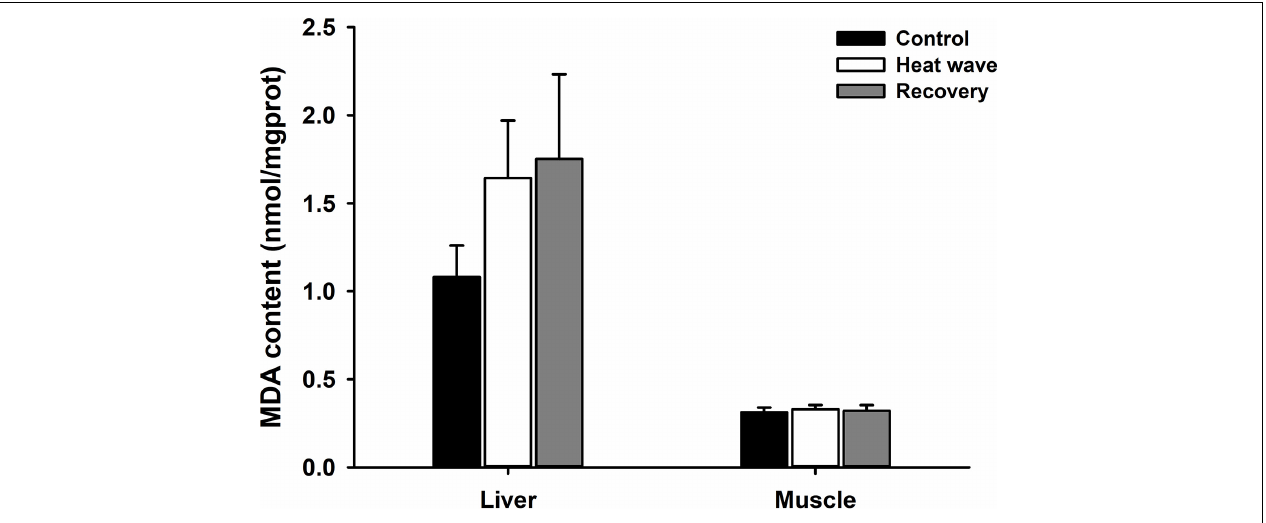
FIGURE 1 | Effects of heat wave on MDA content in the liver and muscle of Mauremys mutica. Data were represented as mean ± standard error (SE).